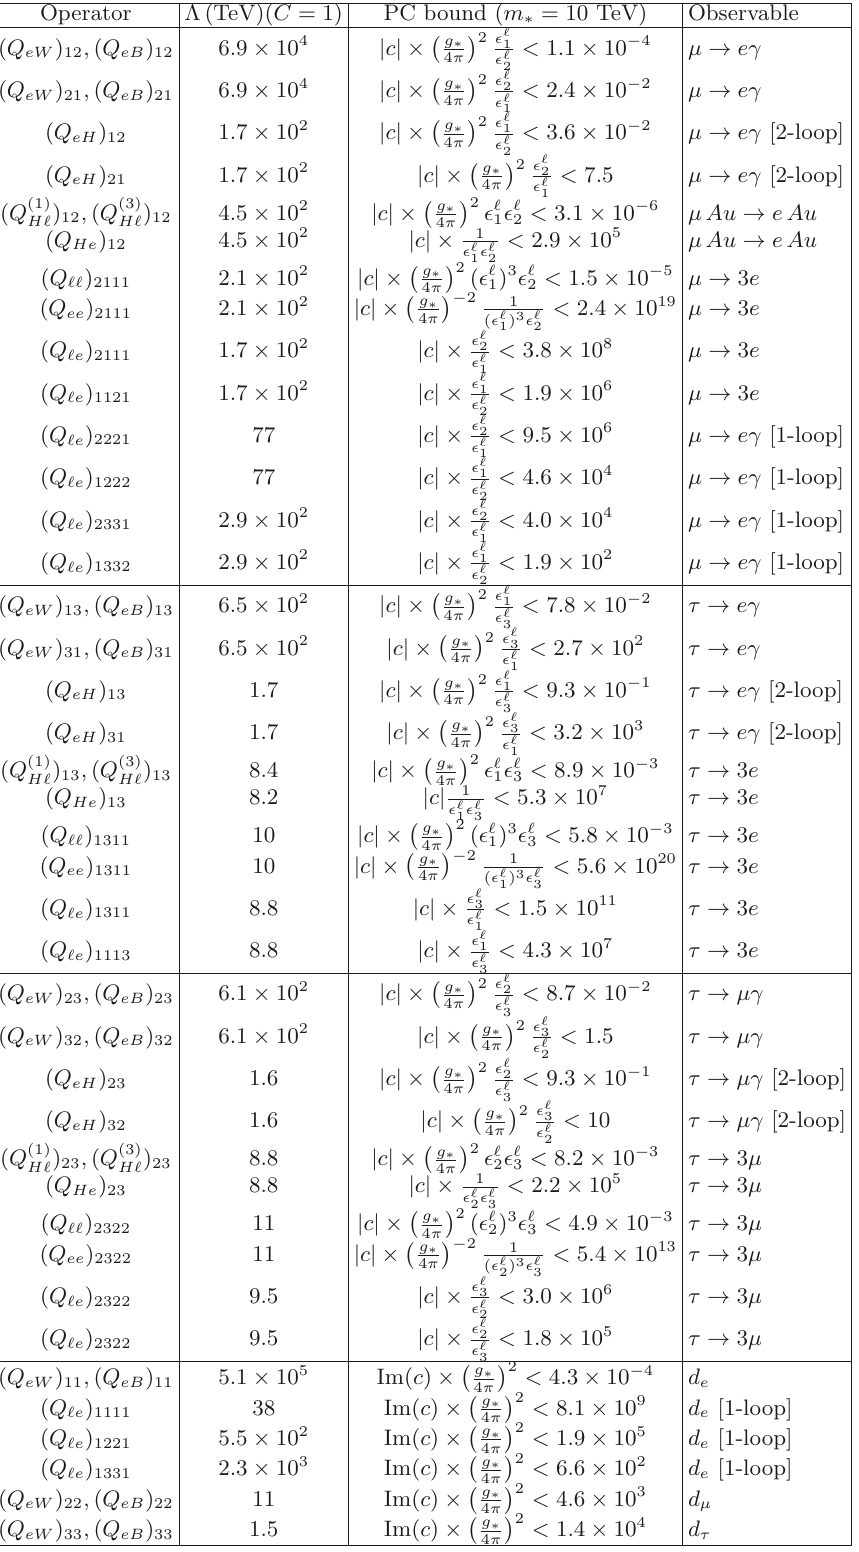
Table 9 . Bounds on Wilson coefficients and corresponding constraints on Anarchic